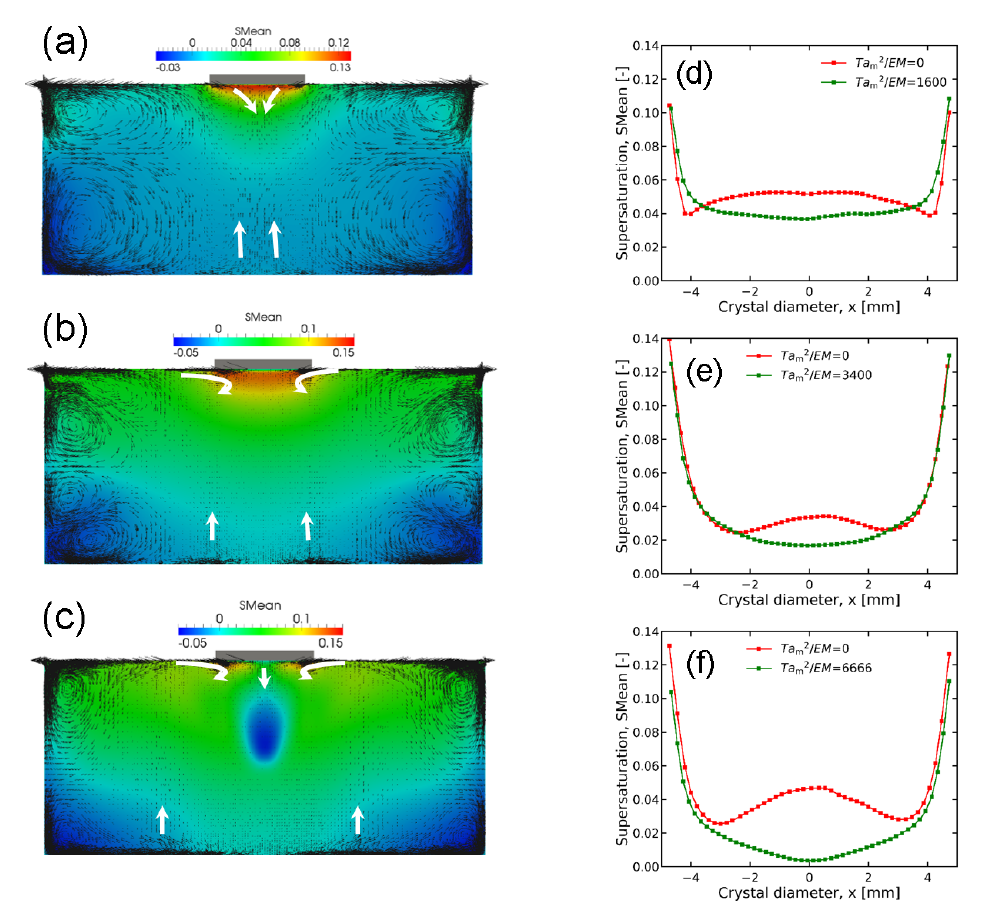
Figure 8. Time-averaged velocity vectors ( a – c ) and supersaturation distribution in the melt along the seed surface ( d – f ) in the melt at the vertical side for ( a , d ) Case 4; ( b , e ) Case 5; and ( c , f ) Case